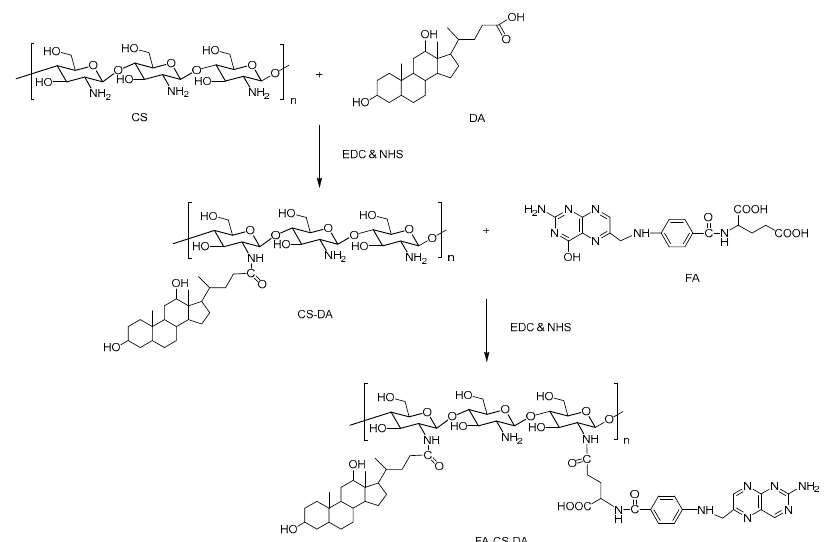
Figure 1. Scheme of the synthesis of FA-CS-DA (folic acid–chitosan–deoxycholic acid).